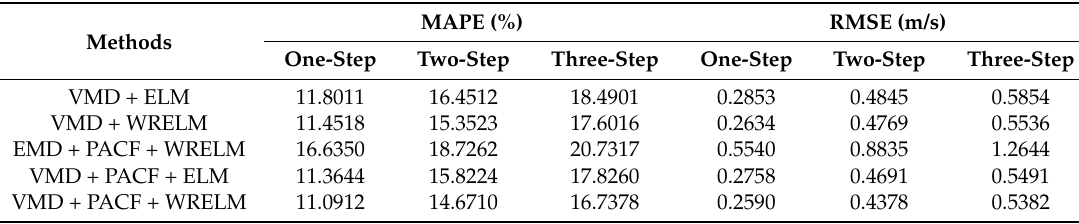
Figure 14. Forecasting results on 20 November 2004, using different methods. Table 5. Mean forecasting error of different methods.